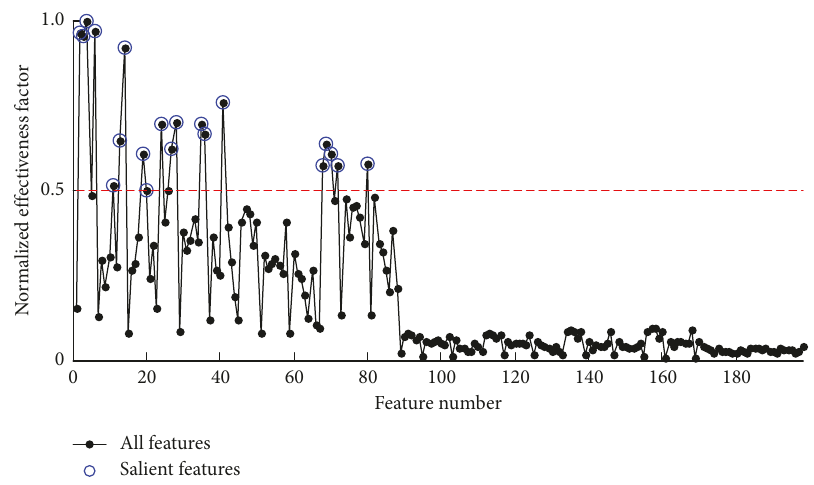
Figure 15: Salient features when ASNBD is applied in experiment 1.